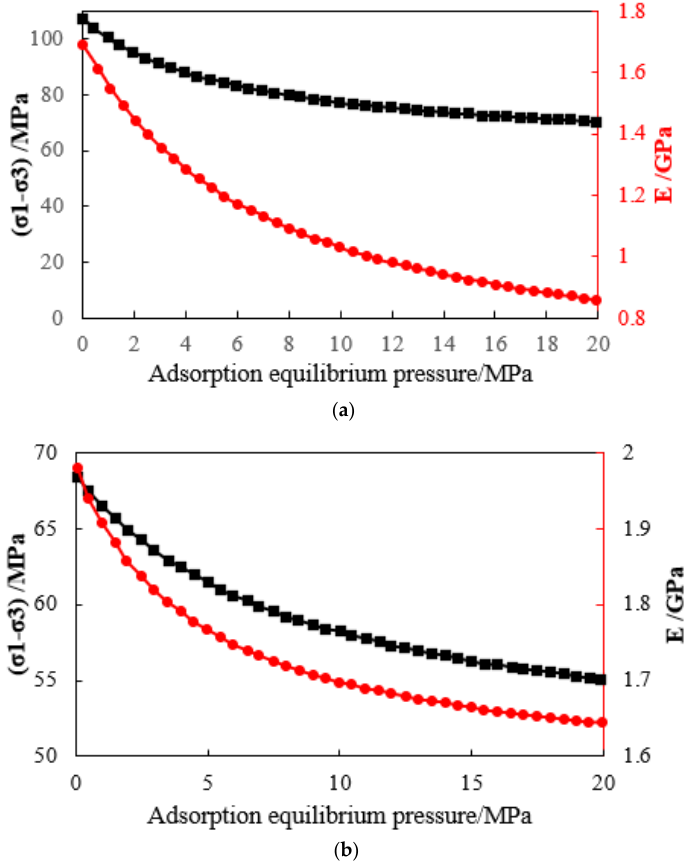
Figure 7. Prediction of compressive strength and elastic modulus of coal samples under different methane adsorption equilibrium pressures. ( a ) Lean coal. ( b ) Gas coal.